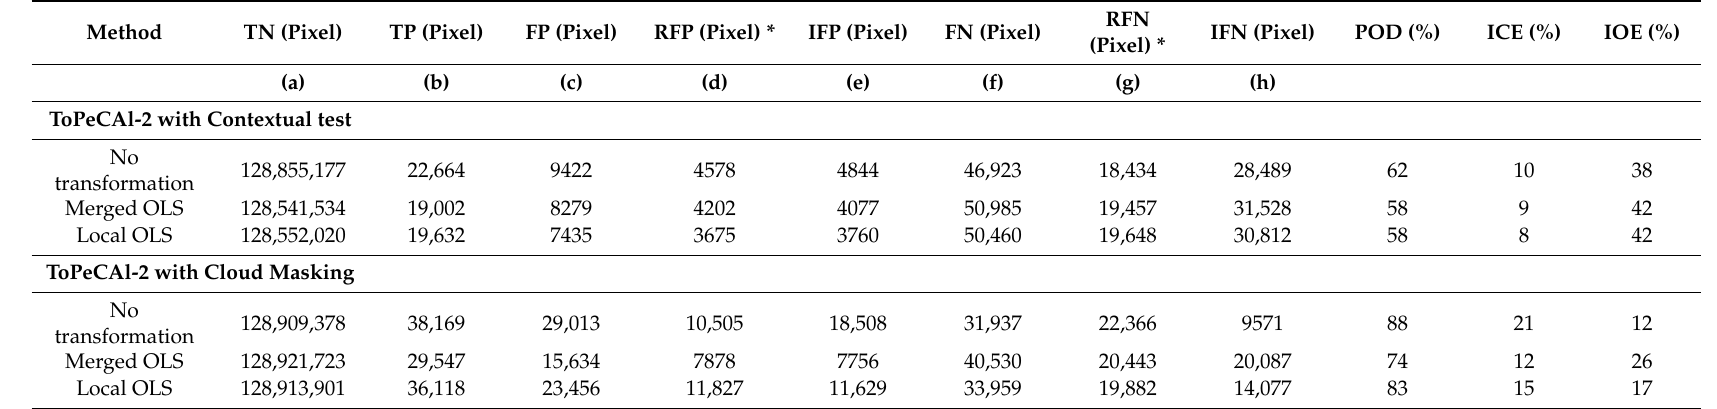
Table A4. Statistical comparison of fires resultant from ToPeCAl-2 with contextual test and ToPeCAl-2 with cloud masking applied to Sentinel-2 MSI compared with fires resultant from ToPeCAl-1 applied to Landsat-8 OLI / TIRS images. The comparison was for one class of fire. The TOA reflectance used in ToPeCAl-2 were with no transformation values and with transformation values from the merged OLS model and local OLS model. (TN = True Negative; TP = True Positive; FP = False Positive; RFP = Related False Positive; IFP = Independent False Positive; FN = False Negative; RFN = Related False Negative; IFN = Independent False Negative; POD = Probability of Detection, ICE = Independent Commission Error, IOE = Independent Omission